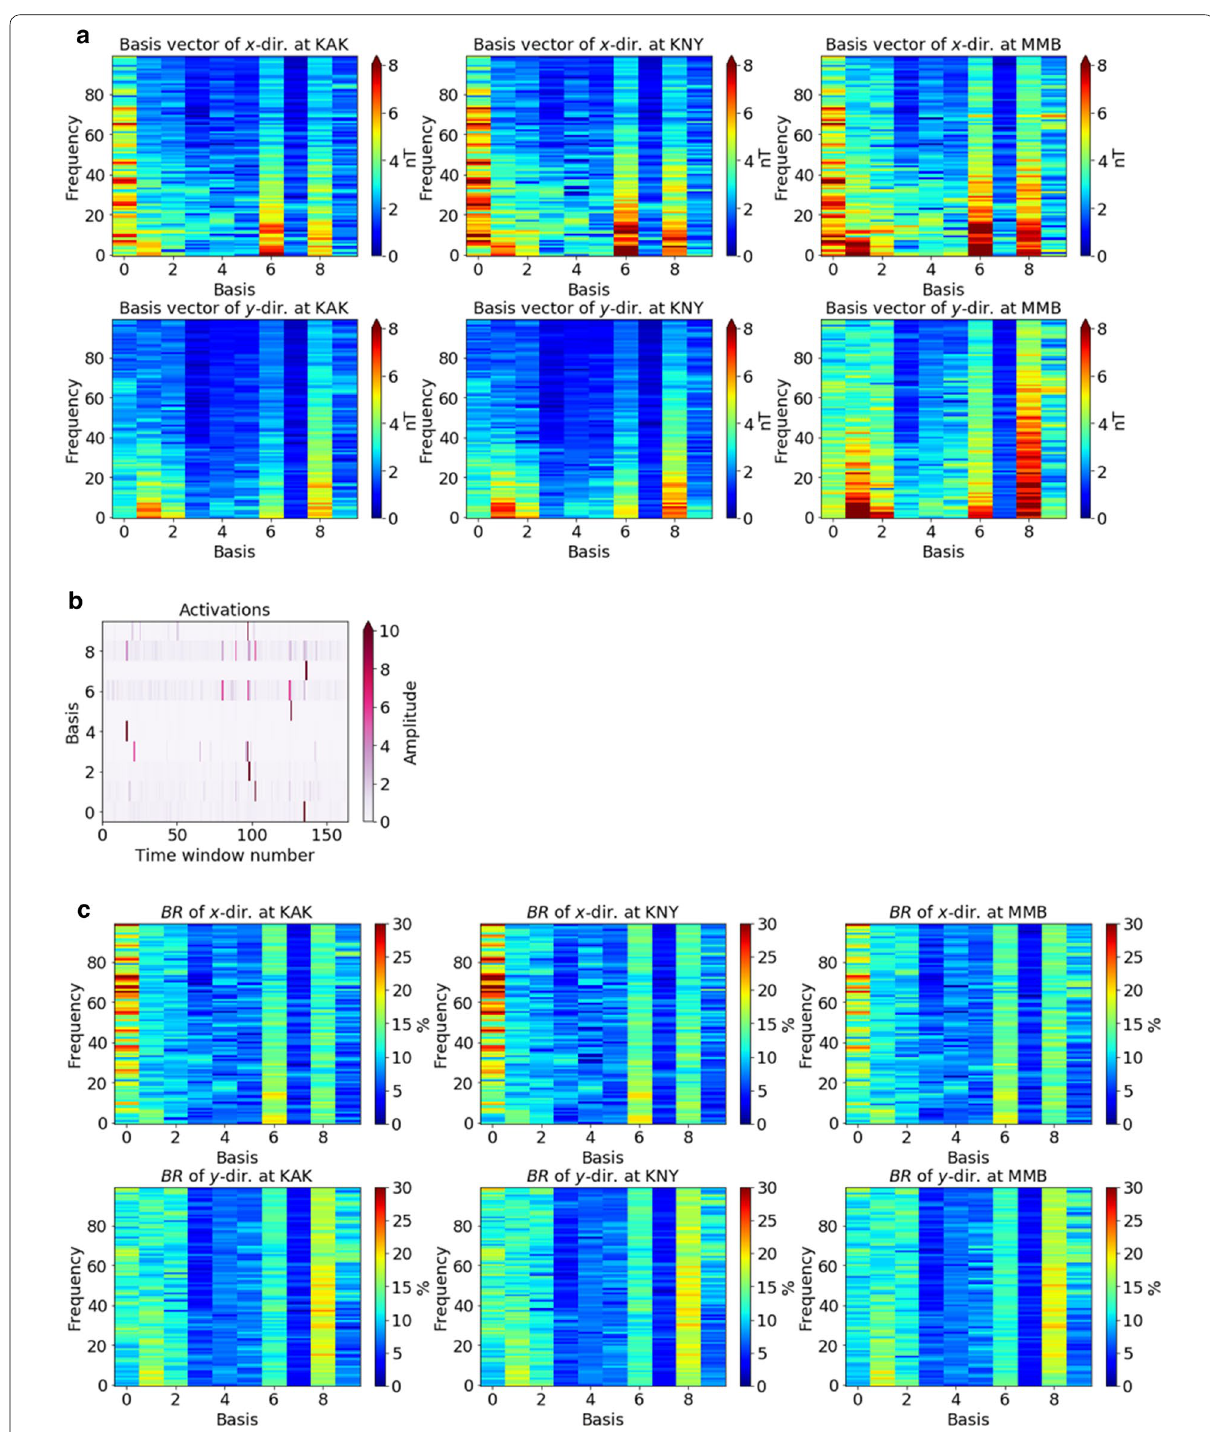
Fig. 4 Results obtained by applying MC‑NMF to the geomagnetic spectrograms from three observatories. a Basis vectors included in the data with x (upper) and y (lower) directions at KAK (left), at KNY (middle), and at MMB (right). The vertical axis denotes frequencies and the horizontal axis denotes IDs of Basis vectors. b Activations. The vertical axis denotes IDs of Activations (same as Basis vectors) and the horizontal axis denotes time window number. c BR with x (upper) and y (lower) directions at KAK (left), at KNY (middle), and at MMB (right). The vertical axis denotes frequencies and the horizontal axis denotes IDs of Basis